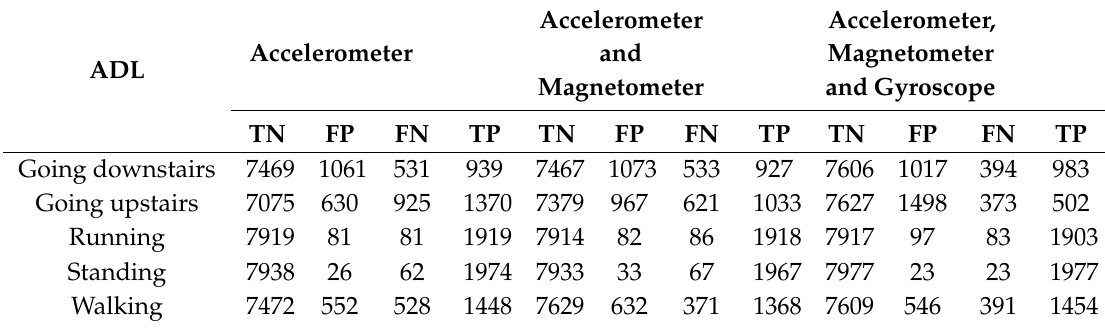
Table 4. Confusion matrix values of ADL recognition using the AdaBoost with the decision